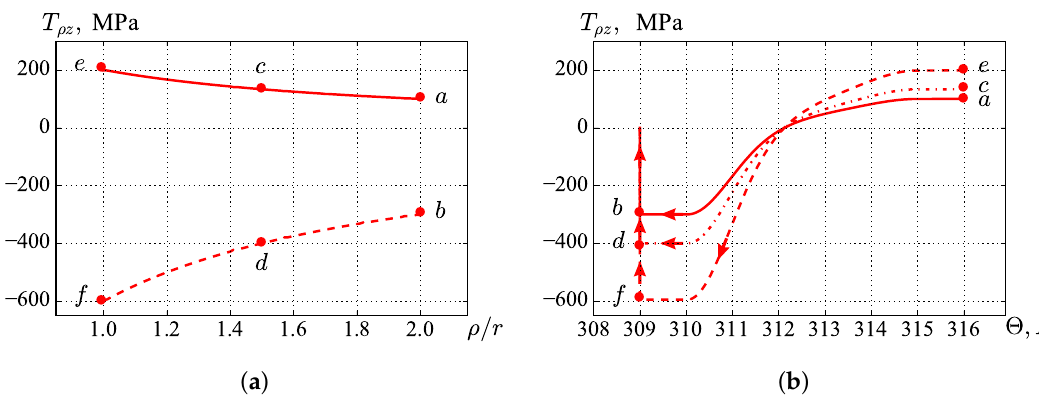
Figure 5. Shear force: distribution along the radius ( a ) and temperature dependence ( b ).